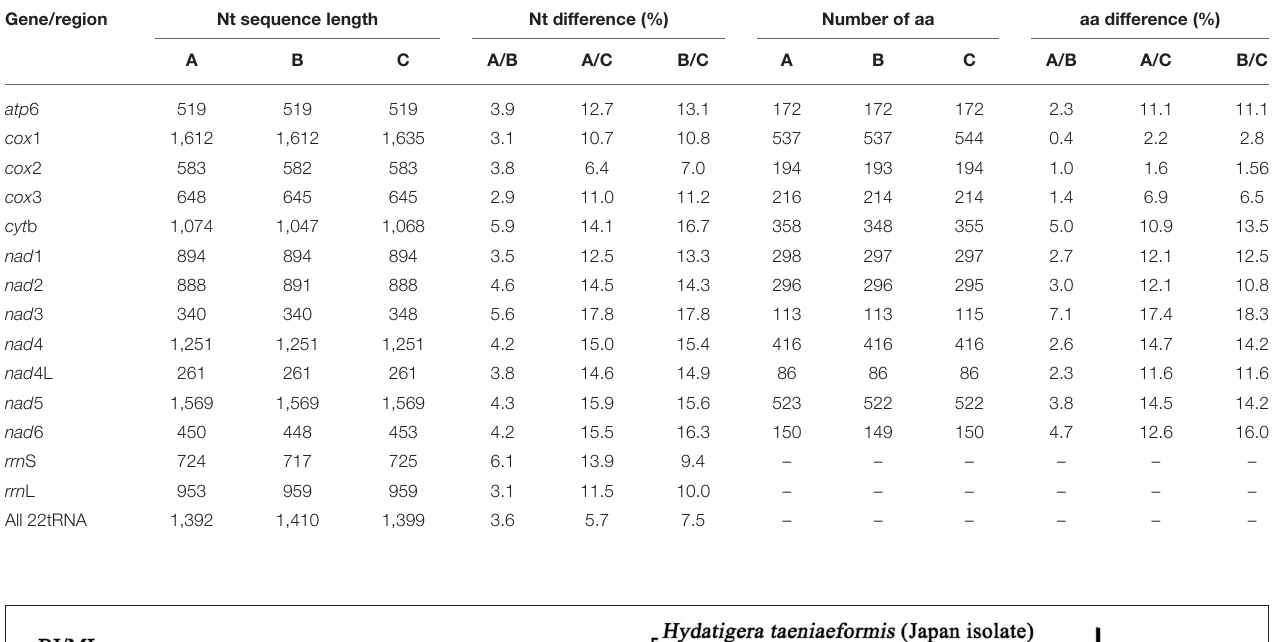
TABLE 2 | Nucleotide (nt) and/or predicted amino acid (aa) sequence differences in mt genes H. taeniaeformis from the leopard cat (HTLC) (A) and H. taeniaeformis from the cat in China (HTCC) (B); HTLC (A) and H. taeniaeformis from the cat in Germany (HTCG) (C); HTCC (B) and HTCG (C) upon pairwise comparison. Gene/region